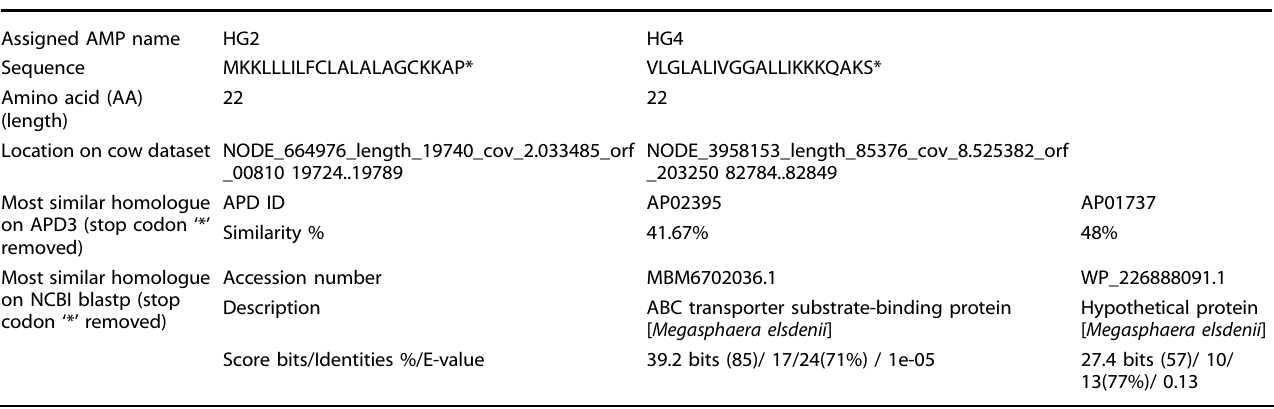
Table 1. Homology of antimicrobial peptides HG2 and HG4 to known sequences.